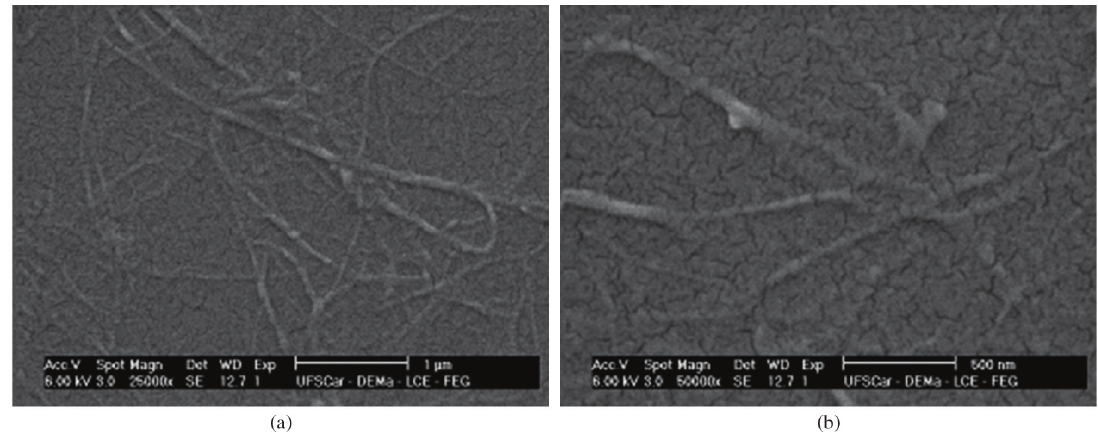
Figure 3. SEM micrographs of cellulose microfibrils with magnifications of (a) 25,000 × and (b) and 50,000